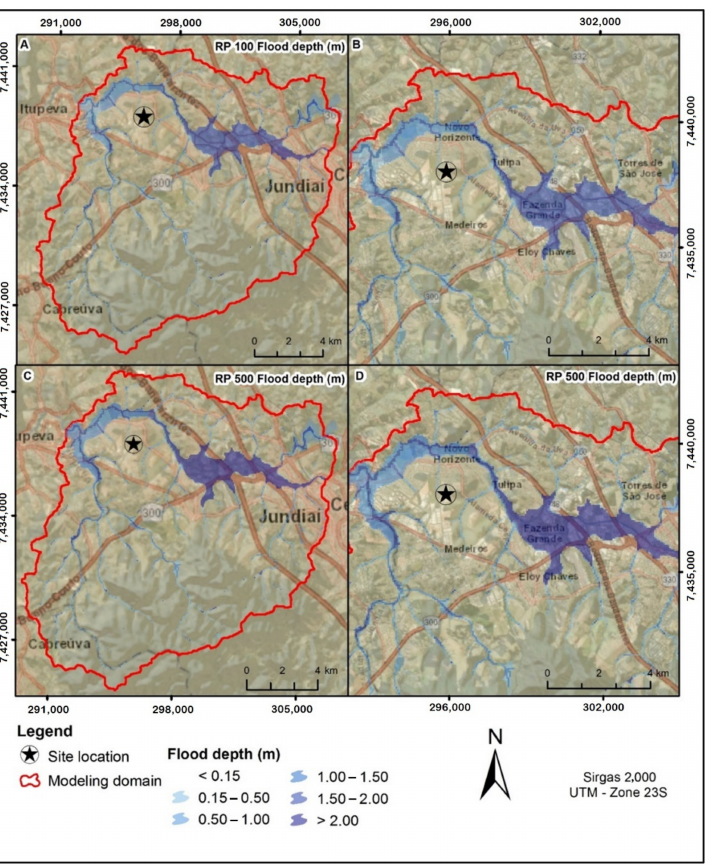
Figure 10. Flood depth results–industrial park. ( A ) Return period (RP) of 100 years design storm. ( B ) RP of 100 years design storm zoomed to industrial park region. ( C ) RP of 500 years design storm. ( D ) RP of 500 years design storm zoomed to industrial park